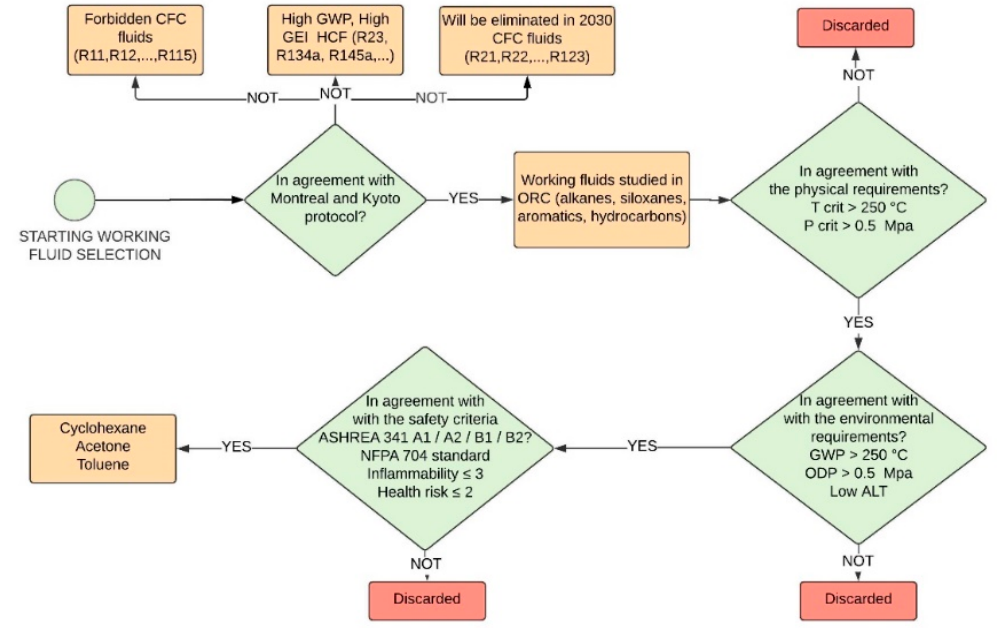
Figure 2. Methodology of working fluids selection.